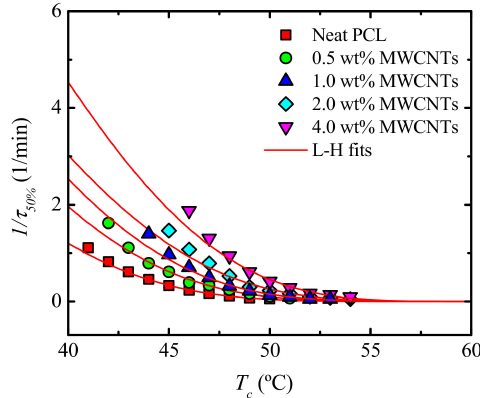
Figure 17. Overall crystallization rate (1/ τ 50% ) as a function of isothermal crystallization temperature ( T c ) for neat PCL and for the PCL/(PC/MWCNT) nanocomposites. The red solid lines represent fits to the LH theory.